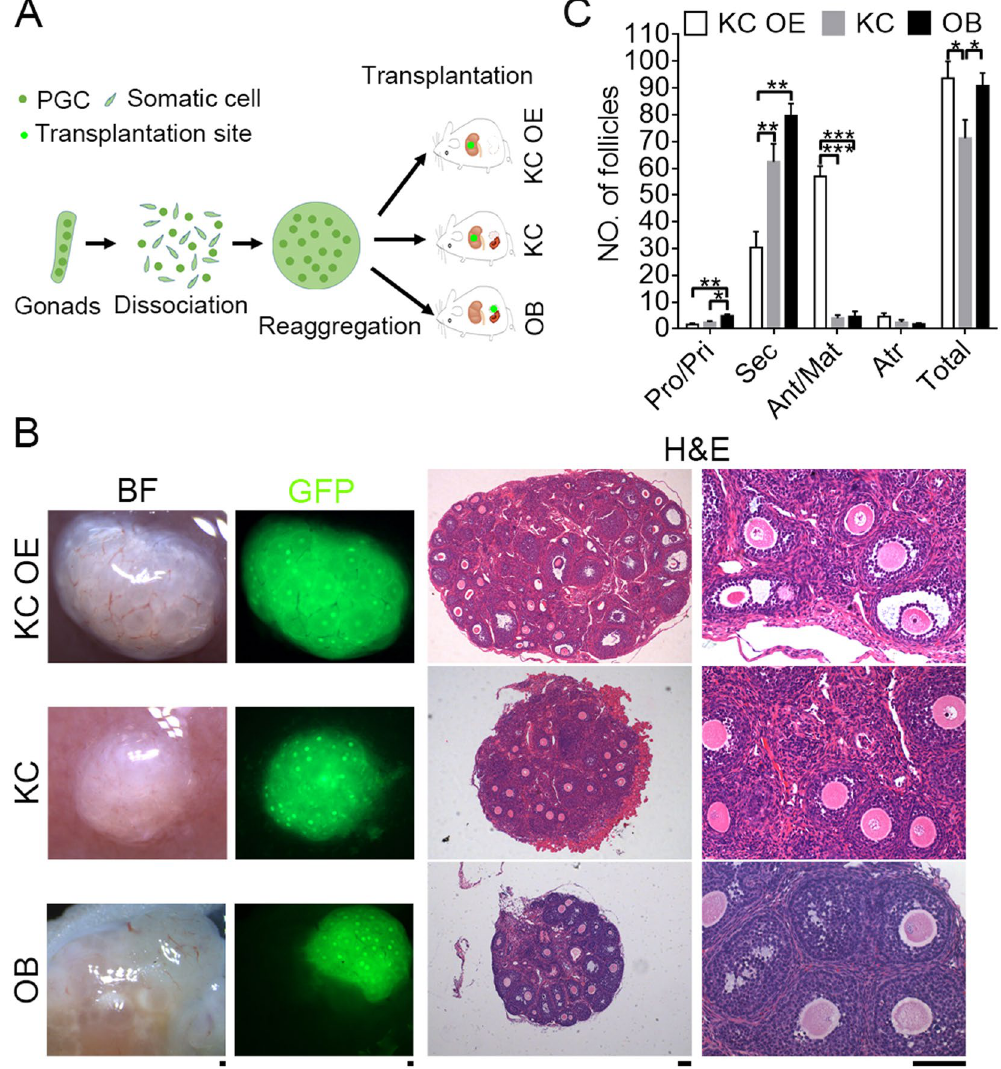
Figure 1. Folliculogenesis in ovary like grafts 28 days following transplantation of PGCs aggregated with gonadal somatic cells. ( A ) Scheme for transplantation procedure and various methods. Female gonads at 12.5- dpc were dissociated, and PGCs aggregated with somatic cells from the same gonad and transplanted under the kidney capsules of bilaterally ovariectomized female recipient mice (KC OE) or the kidney capsules (KC) or the ovarian bursa (OB) of female recipient mice with ovaries. ( B ) Morphology of ovary like grafts 28 days after transplantation using three methods. Follicles in ovary like grafts were readily visible by GFP fluorescence and also shown in sections by H&E staining. Scale bar = 100 μ m. ( C ) Number of follicles at various developmental stages in the grafts by different methods of transplantation. Primordial/Primary (Pro/Pri), Secondary (Sec), Antral/Mature (Ant/Mat), Atretic (Atr). Data represents Mean ± SEM (n = 5 mice per group). * P < 0.05; ** P < 0.01; *** P <